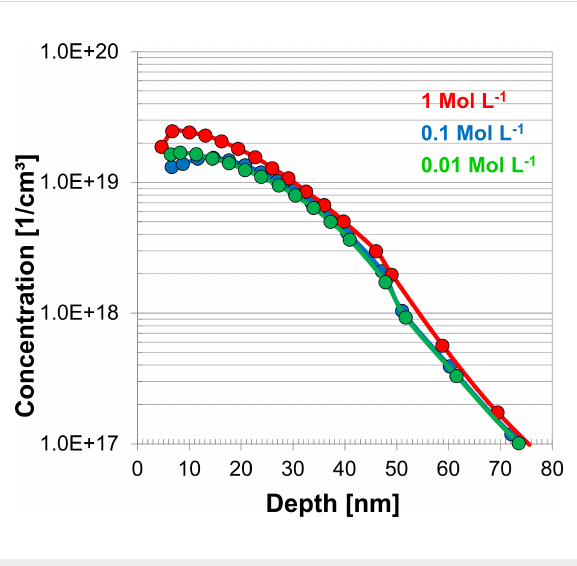
Figure 5: ECV plot of active carrier concentrations using bulk silicon samples to analyse the variation of the molecule concentration during functionalization. A 50 nm sputtered SiO 2 cap and annealing at 1050 °C for 5 s was used for all samples.